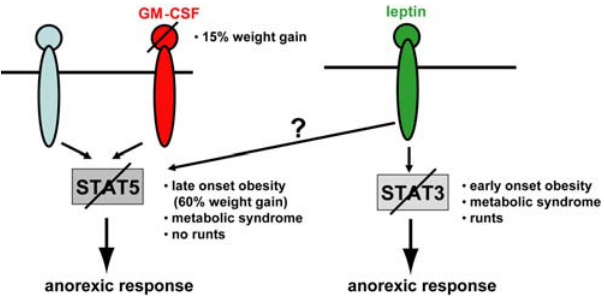
Figure 11. Summary diagram of cytokine signaling pathways controlling body weight. While leptin preferentially signals through STAT3, GM-CSF utilizes STAT5. However, since the GM-CSF-null mice develop milder symptoms than the STAT5-mutant mice described in this study, we propose that some of the STAT5 signaling is induced by leptin or yet another unknown